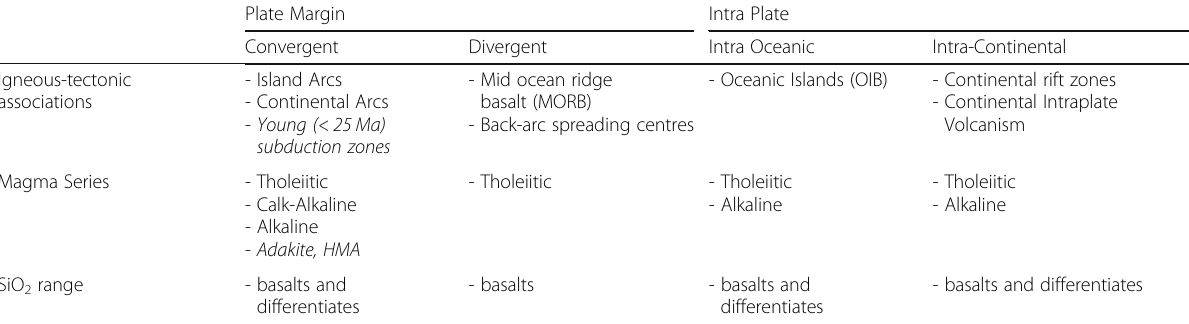
Table 2 Igneous-tectonic associations, modified after Wilson